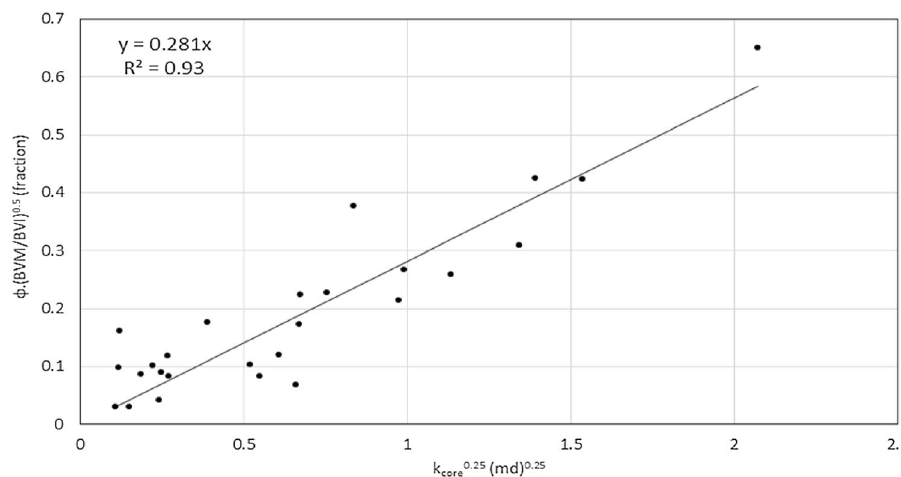
Fig. 6 Determination of C value in TC model ( m = 4, n = 2)